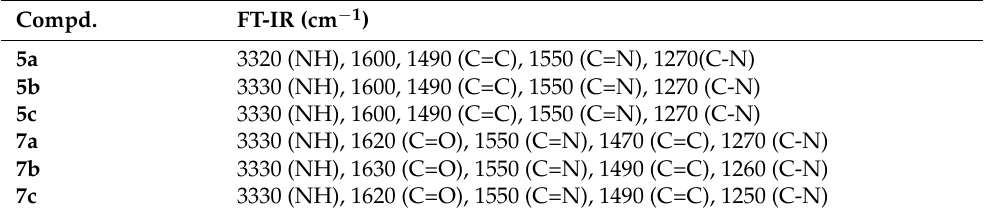
Table 1. FT-IR data for prepared polymers 5a – c & 7a – c . Compd.